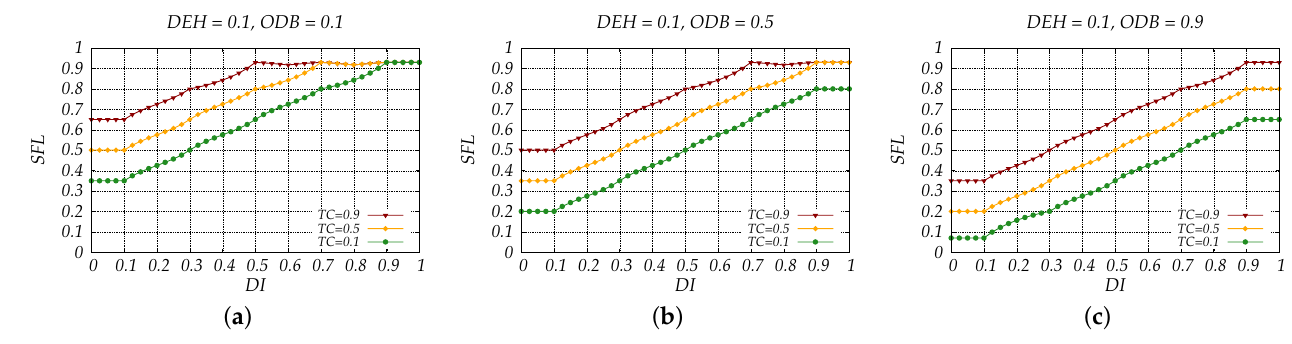
Figure 6. Simulation results showing the effect of ODB, TC, and DI on the determination of driver stress when DEH = 0.1. ( a ) DEH = 0.1, ODB = 0.1, ( b ) DEH = 0.1, ODB = 0.5, ( c ) DEH = 0.1, ODB = 0.9.